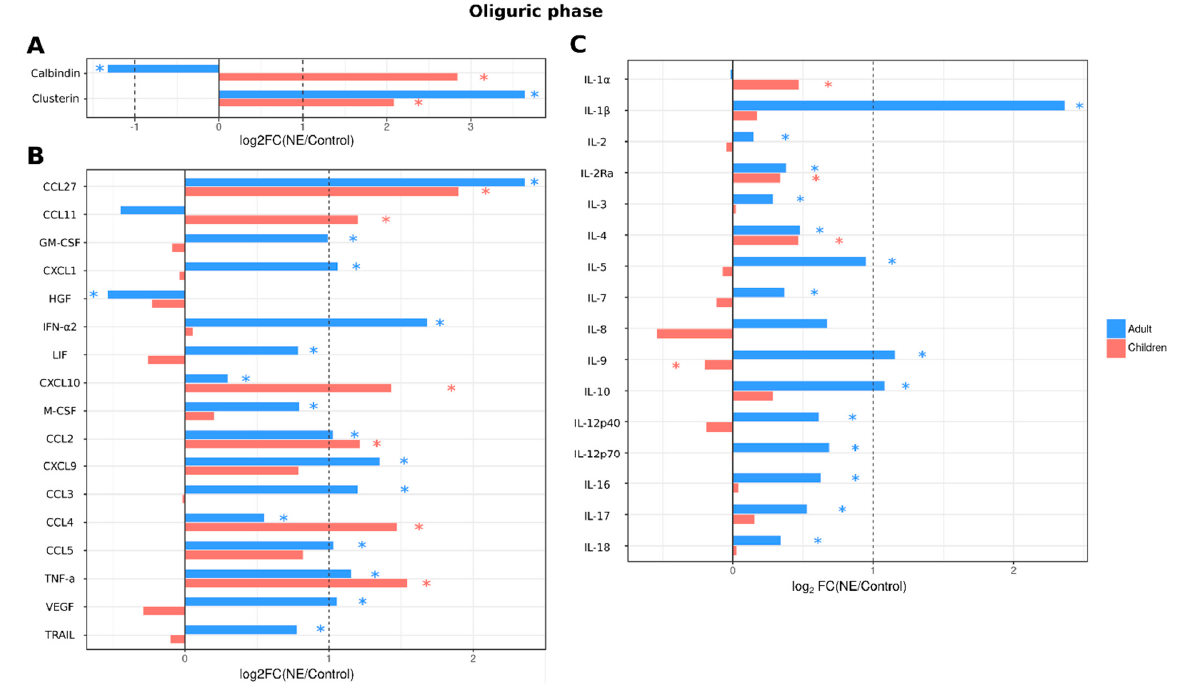
Figure 5. Analysis of serum cytokine and kidney toxicity markers in adults and children diagnosed with NE in oliguric phase. The Bio-Plex (Bio-Rad, Hercules, CA, USA) multiplex magnetic bead-based antibody detection kit was used to measure ( A ) markers of kidney toxicity in the urine; ( В ) serum chemokines or ( С ) serum interleukins in adults ( n = 129) and children ( n = 11). Data are presented as Log2 fold change in comparison to non-NE control samples. Asterisks denote statistical significance determined by Kruskal-Wallis test with BH adjustment ( p < 0.05). Dotted line indicates fold change of 1.